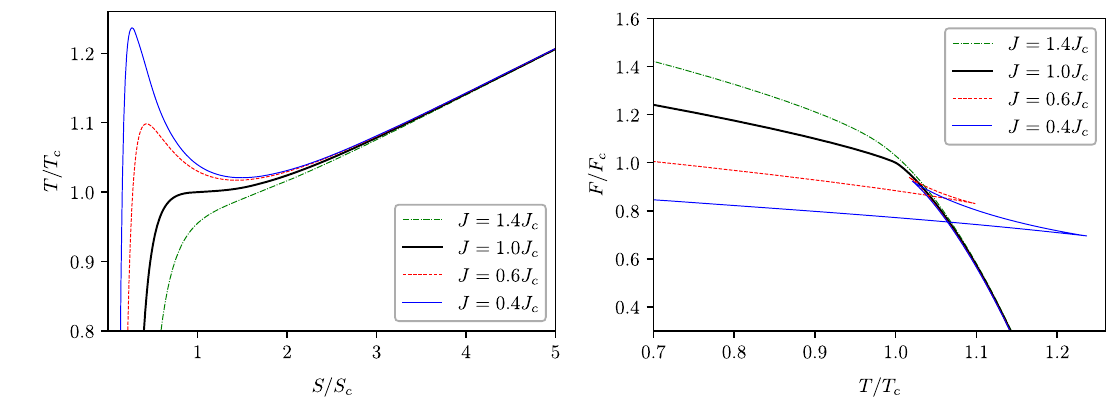
Fig. 1 T − S and F − T curves at fixed J >